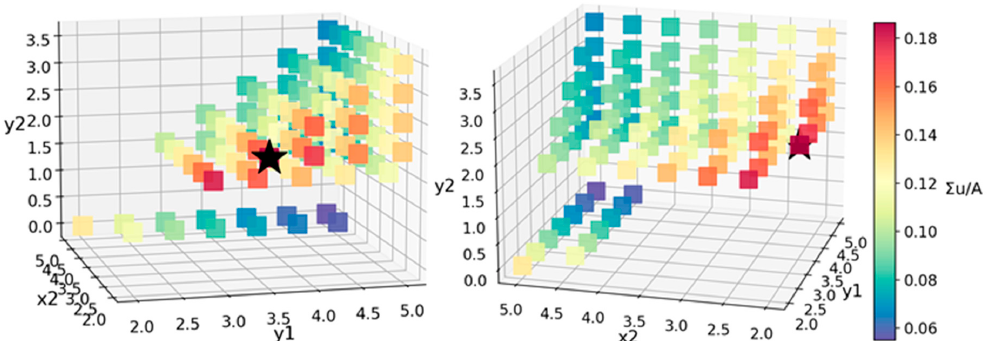
Figure 14. The three-dimensional scatter diagram of array power density (truncation ratio is 0.6). The missing scatters represent that the inflow velocity under this distance parameters is less than the truncation ratio. The left and right pictures are two different side views of the scatter. The three axes are the three distance parameters ( y 1, x 2, y 2). The color bar represents the array power density. The black star represents the maximum array power density (Its coordinates are y 1 = 3.5, x 2 = 2, y 2 = 2).